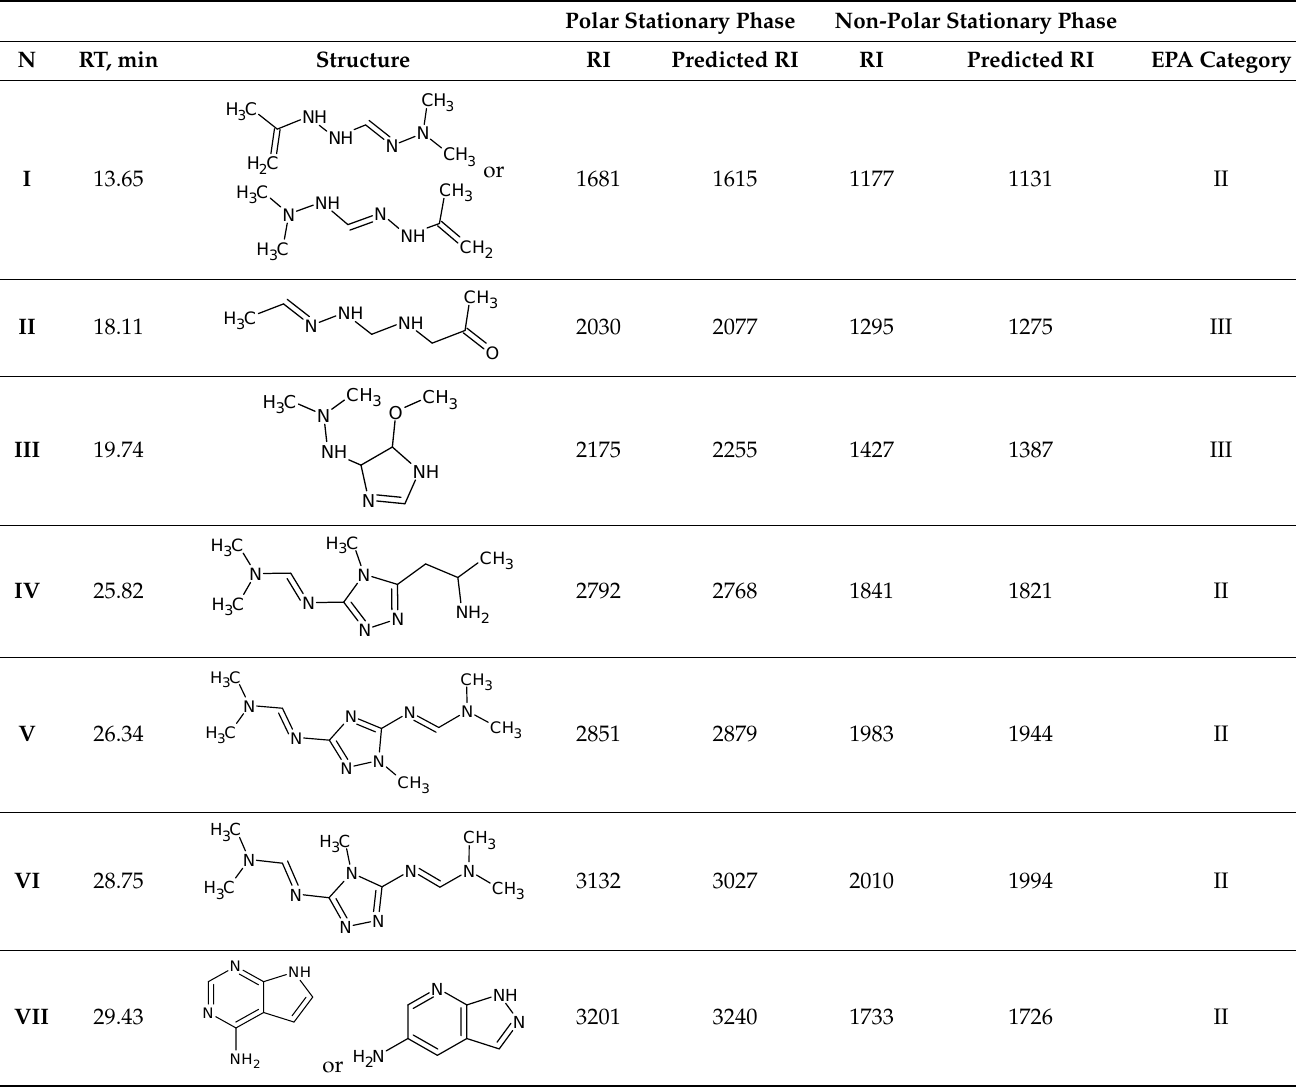
* Asterisks denote compounds for which the NIST 17 database contains reference mass spectra. Re- tention time (RT) and retention index (RI) for the polar stationary phase are listed. In two specially denoted cases, the reference RI are available in the NIST database, and these values are listed instead of the predicted ones. For such cases when the structures of proposed candidates were refined using new criteria, the previously proposed structures are indicated in parentheses. Table 3. Proposed structures of detected unsymmetrical dimethylhydrazine transformation products. Retention time (RT) and retention index (RI) for the polar stationary phase, and RI for the non-polar stationary phase are given. The EPA acute toxicity category is also given.